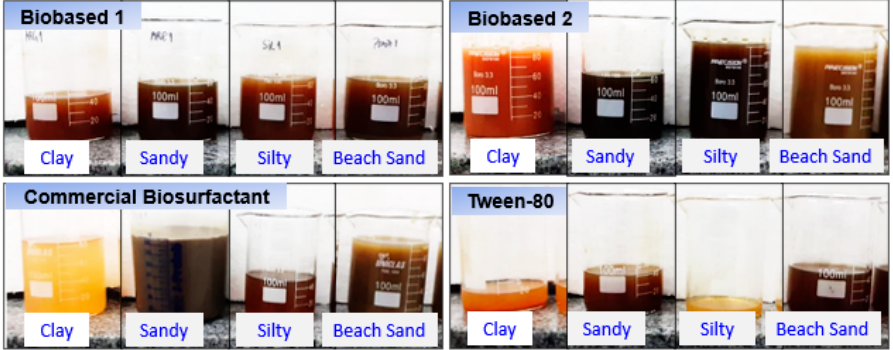
Figure 9. Illustrations showing the tested surfactant washing solutions (biobased 1, biobased 2, formulated biosurfactant, and Tween 80) after hydrocarbon removal through kinetic assay from soils (clay, sandy, silty, and beach sand).